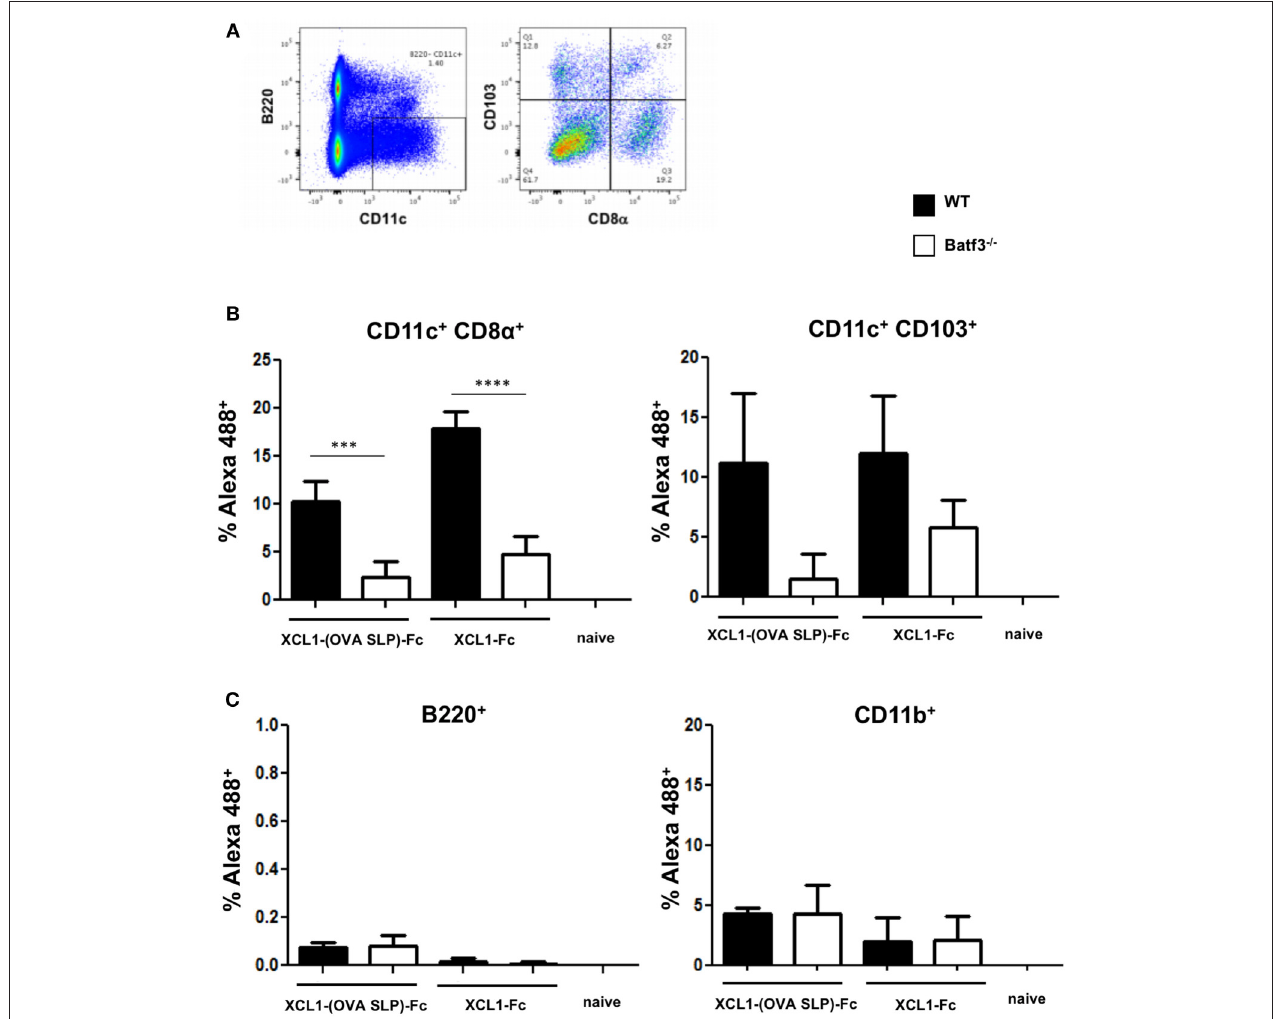
FIGURE 2 | In vivo uptake of Xcl1-(OVA SLP)-Fc in skin draining LN. WT and Batf3 KO mice were injected intradermally in the footpad with a mix of 50 µ g of CpG and 6 µ g of Alexa 488-labeled Xcl1-(OVA SLP)-Fc or Xcl1-Fc fusion proteins. Inguinal LNs were harvested 16h post injection and the uptake of labeled fusion proteins was measured in different populations of APCs, (A) gating strategy for identifying CD103 + and CD8 α subtypes in CD11c + B220 neg DCs isolated from inguinal LNs. (B) Uptake of labeled Xcl1-fusion proteins by CD8 α DCs (left), CD103 + DCs (right), and (C) B220 + B cells (left), and CD11b macrophages (right). Data are shown as mean + /- SEM ( n = 3–4 mice/group). Results are representative of two independent experiments. *** p < 0.001, **** p < 0.0001.